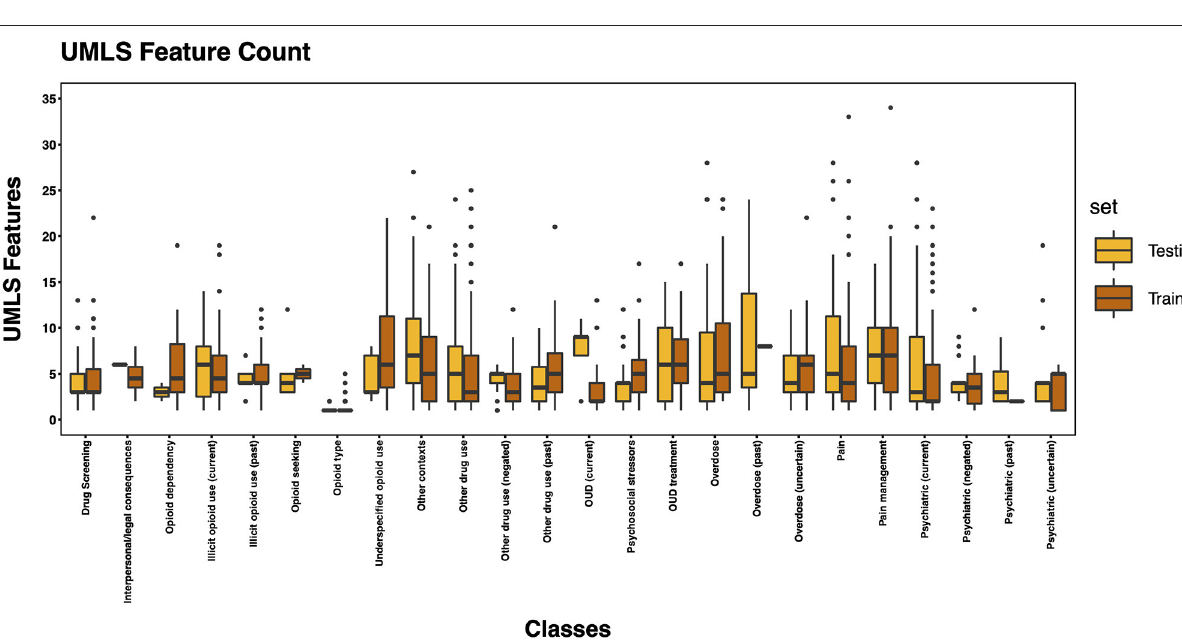
In general, drops in performance for training vs.